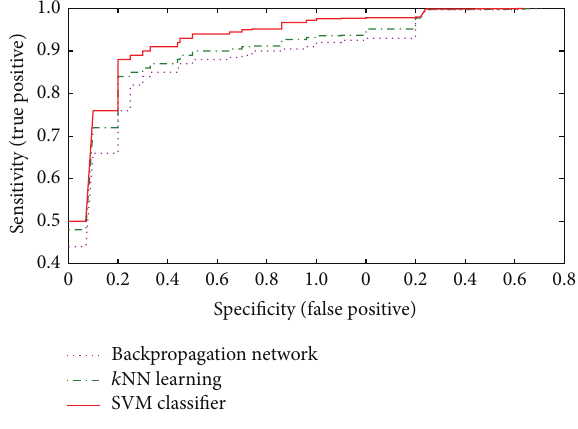
Figure 9: Classification accuracy for the considered classifiers. Figure 10: ROC curve for various